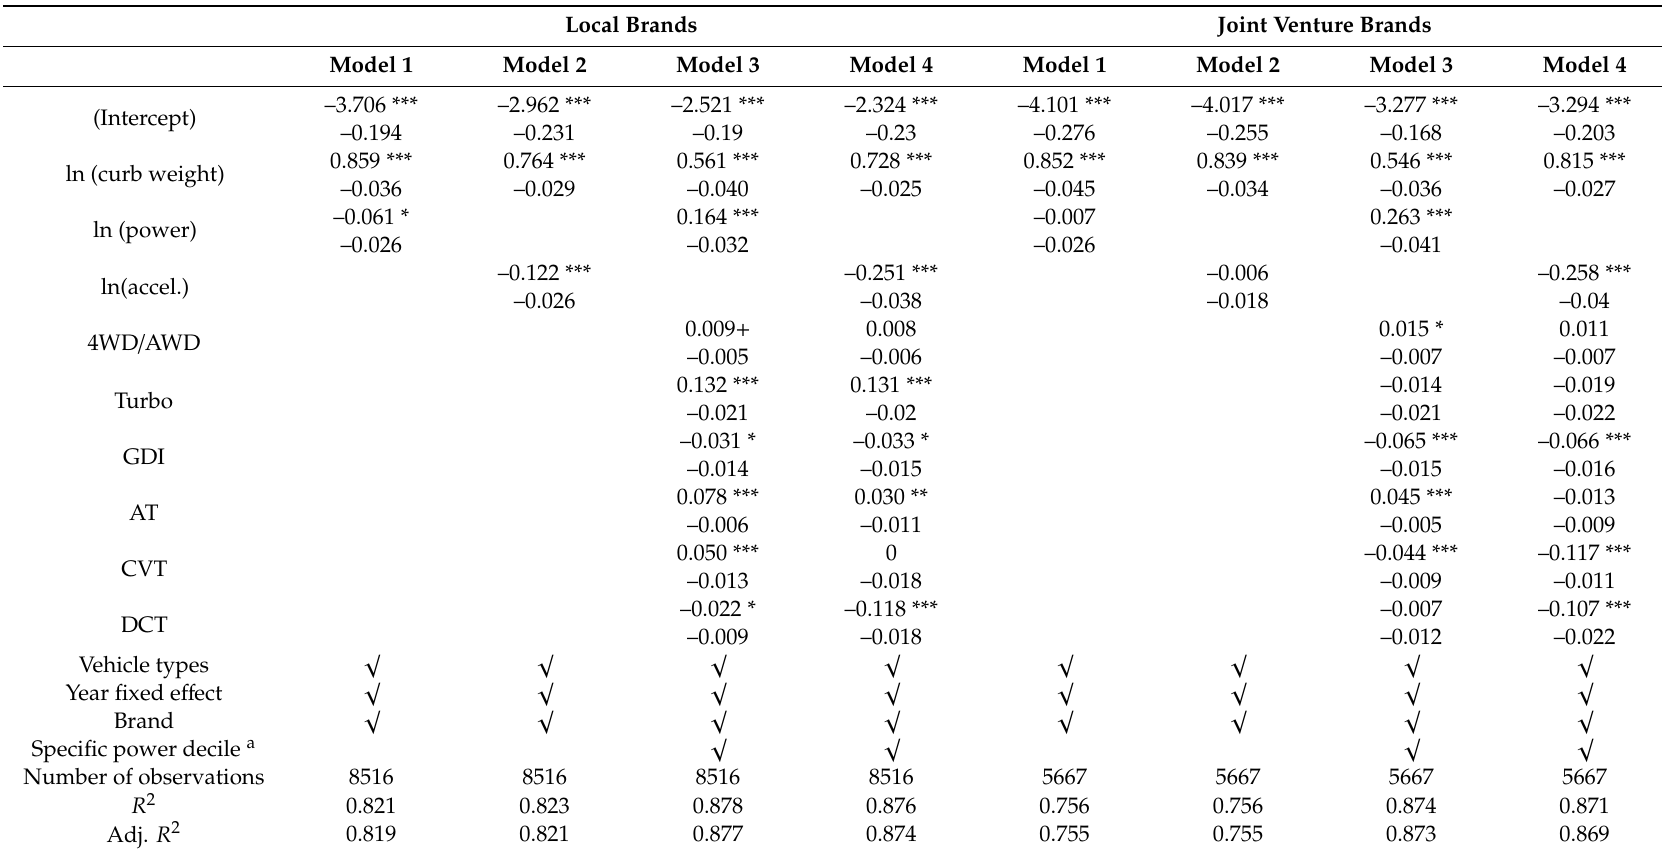
Table 1. Results of estimating regression models of passenger vehicle FCR as a function of curb weight, power, acceleration time, and other